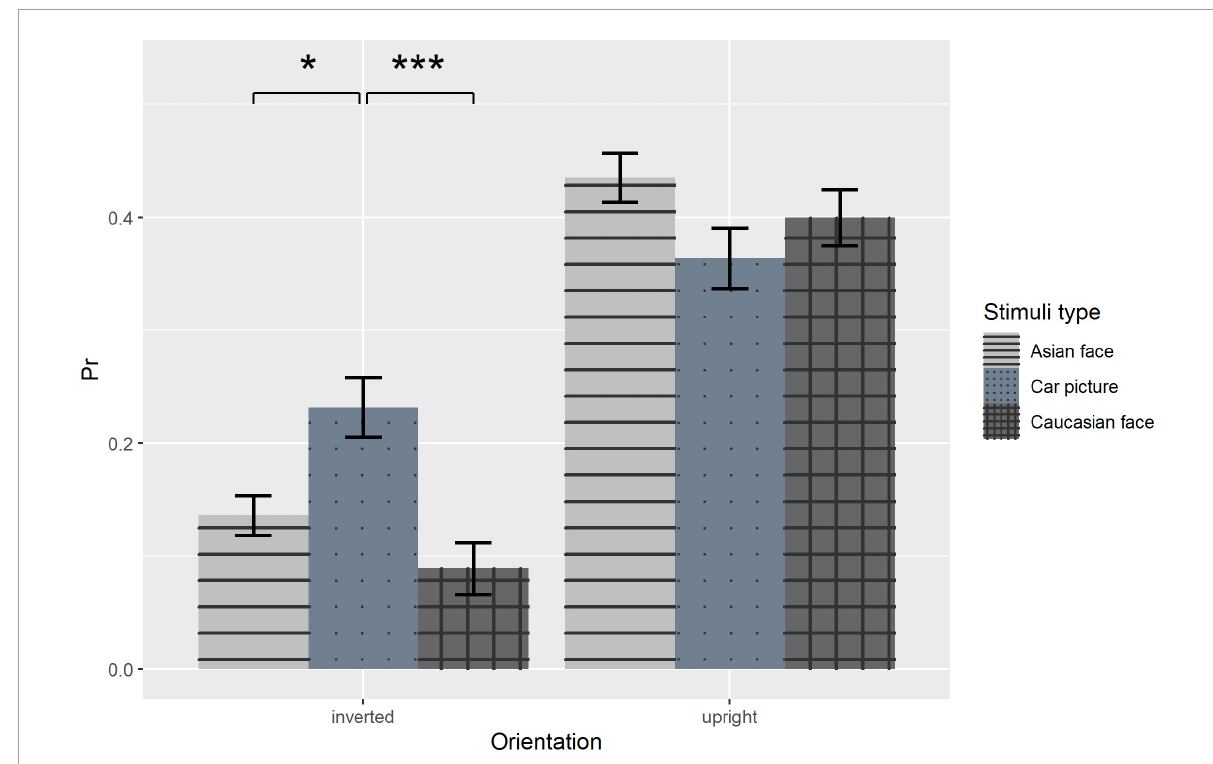
FIGURE2 Recognition performance as a function of orientation and stimuli type. Error bars represent standard errors. * p < 0.05, *** p <